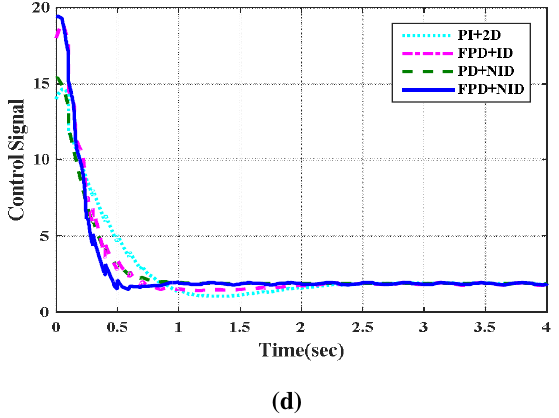
Fig. 11. Unity step simulation results with nonlinear sinusoidal disturbance and parameter uncertainty: (a) angular position; (b) angular velocity; (c) error signal; (d) control signal . .